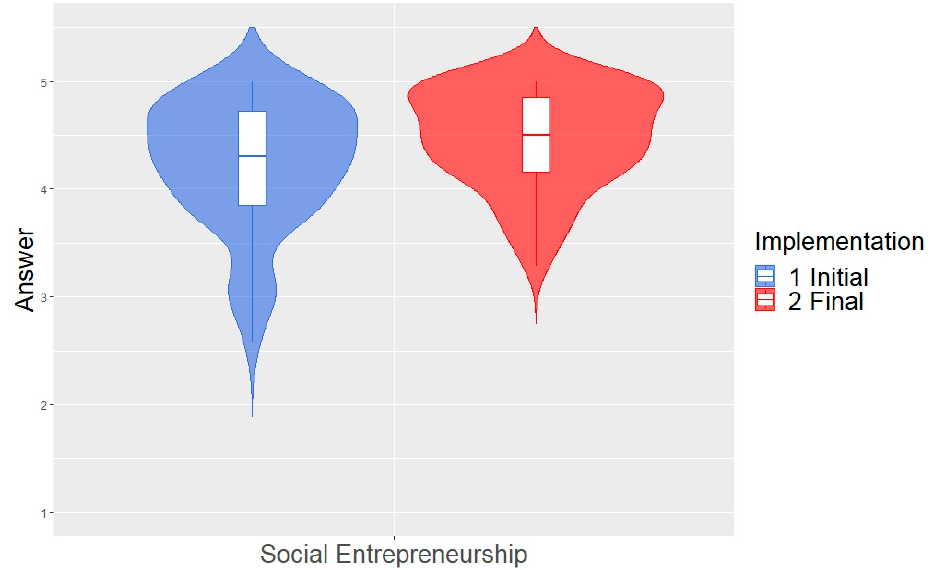
Figure 1. Social entrepreneurship competency results (Initial–Final).